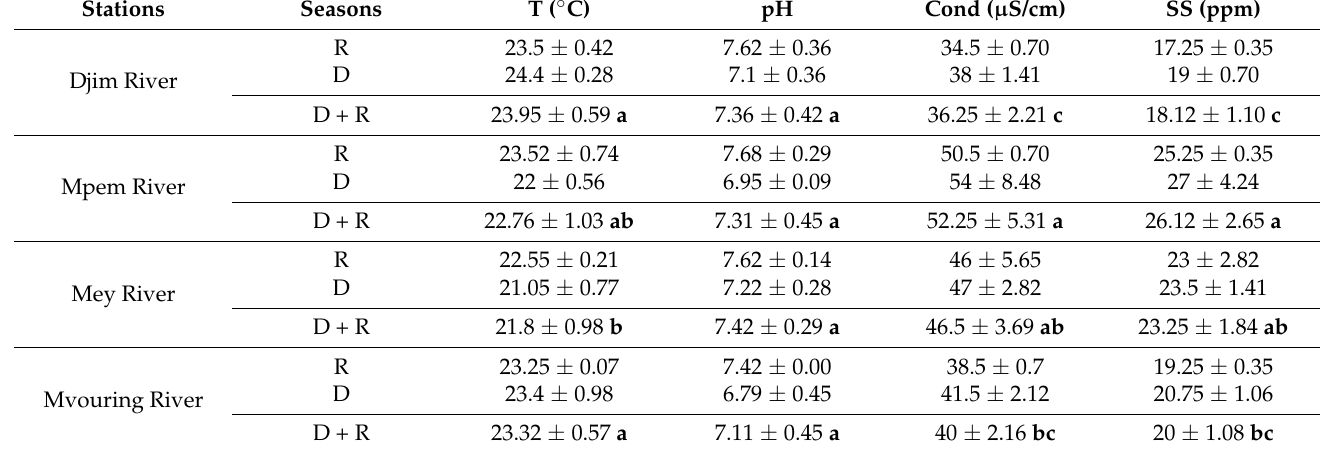
Table 2. Values of the physicochemical parameters measured in the rivers of the Mpem and Djim Na- tional Park during sampling events: average ± standard error, Cond = conductivity, SS = suspended solids, pH = hydrogen potential, R = rainy season, D = dry season, T = temperature. For the sampling site comparisons, values assigned with different letters (a, b, or c) in a given column are statistically different and those with the same letter are not different from the 5% threshold; no letters were used for seasonal comparisons as there are no statistically significant differences between